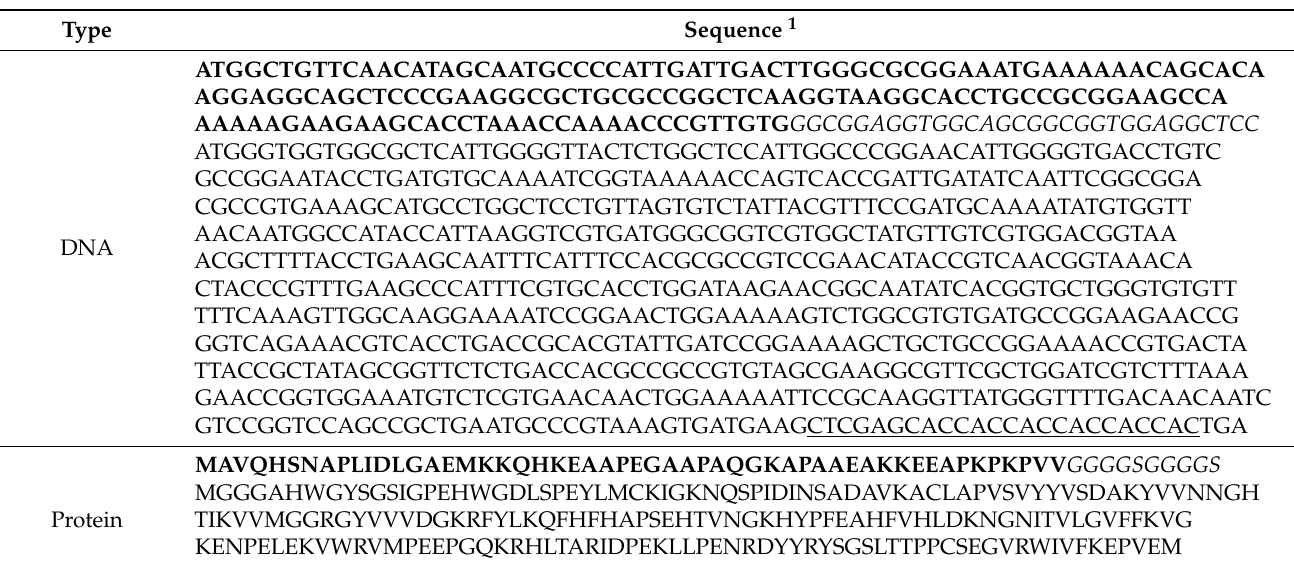
Table 2. DNA and protein sequences of NEXT-taCA used in this